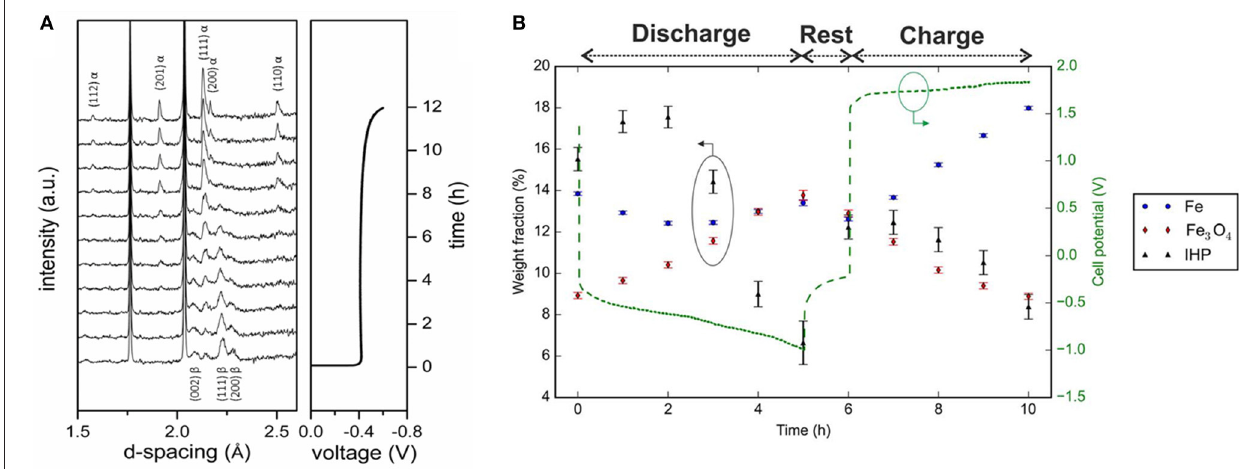
FIGURE 2 | (A) Neutron diffraction patterns from the cell collected in-situ using an MH electrode (AB 5 -type alloy) and Ni mesh as negative and positive electrodes, respectively. The cell potential vs O 2 /H 2 measured during the in-situ experiment is also presented, (B) Plot showing weight fraction and the cell potential vs. O 2 /H 2 as a function of time using a Fe electrode and Ni mesh as anode and cathode, respectively.